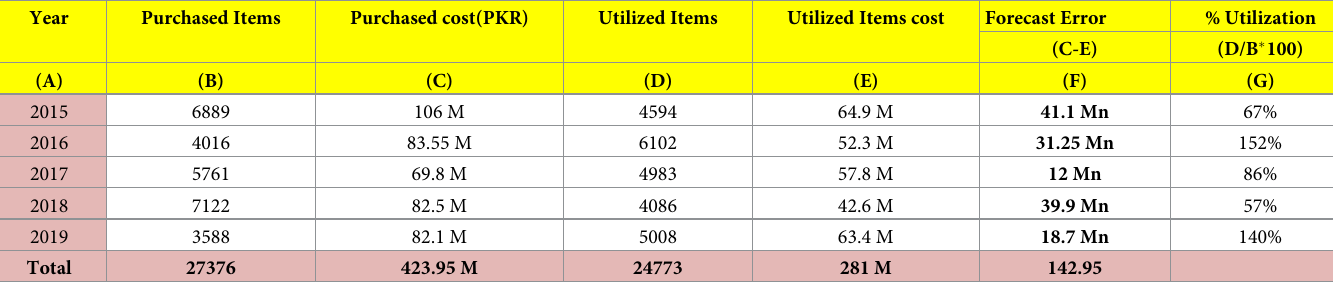
Table 2. Forecast errors in forecasted/utilized spares parts